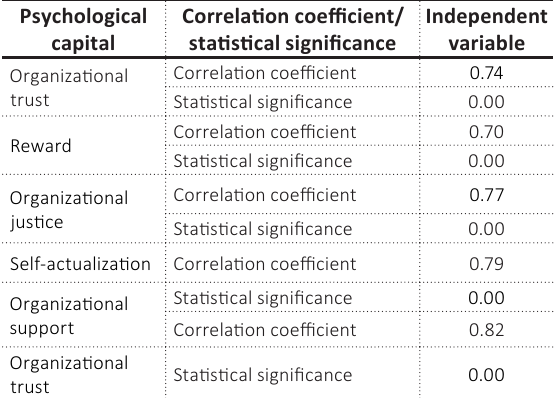
Table 7. Pearson correlation coefficient results for the relationship between leadership behavior